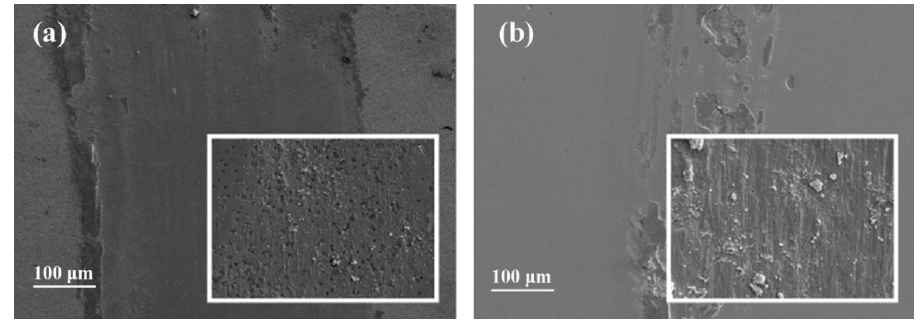
Figure 10. SEM image of worn track of NbCN-Ag composite films with different Ag contents: ( a ) 2.0 at.%; ( b ) 12.9 at.%.